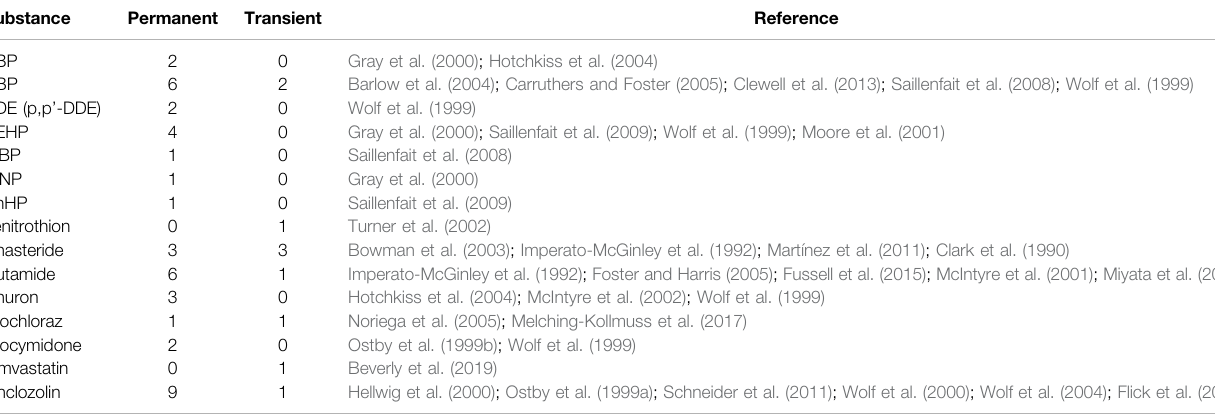
TABLE 3 | Nipple retention (NR) as a permanent or transient effect.